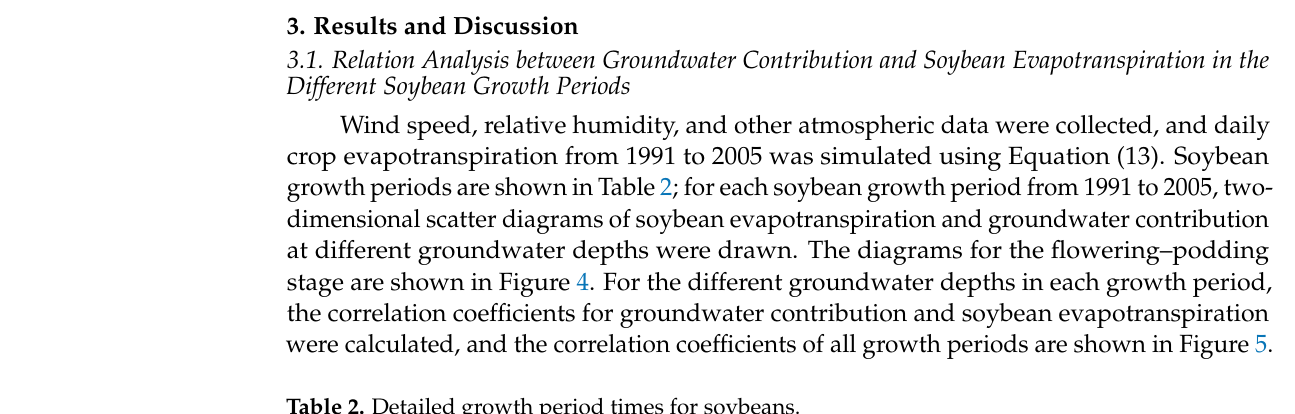
Table 2. Detailed growth period times for